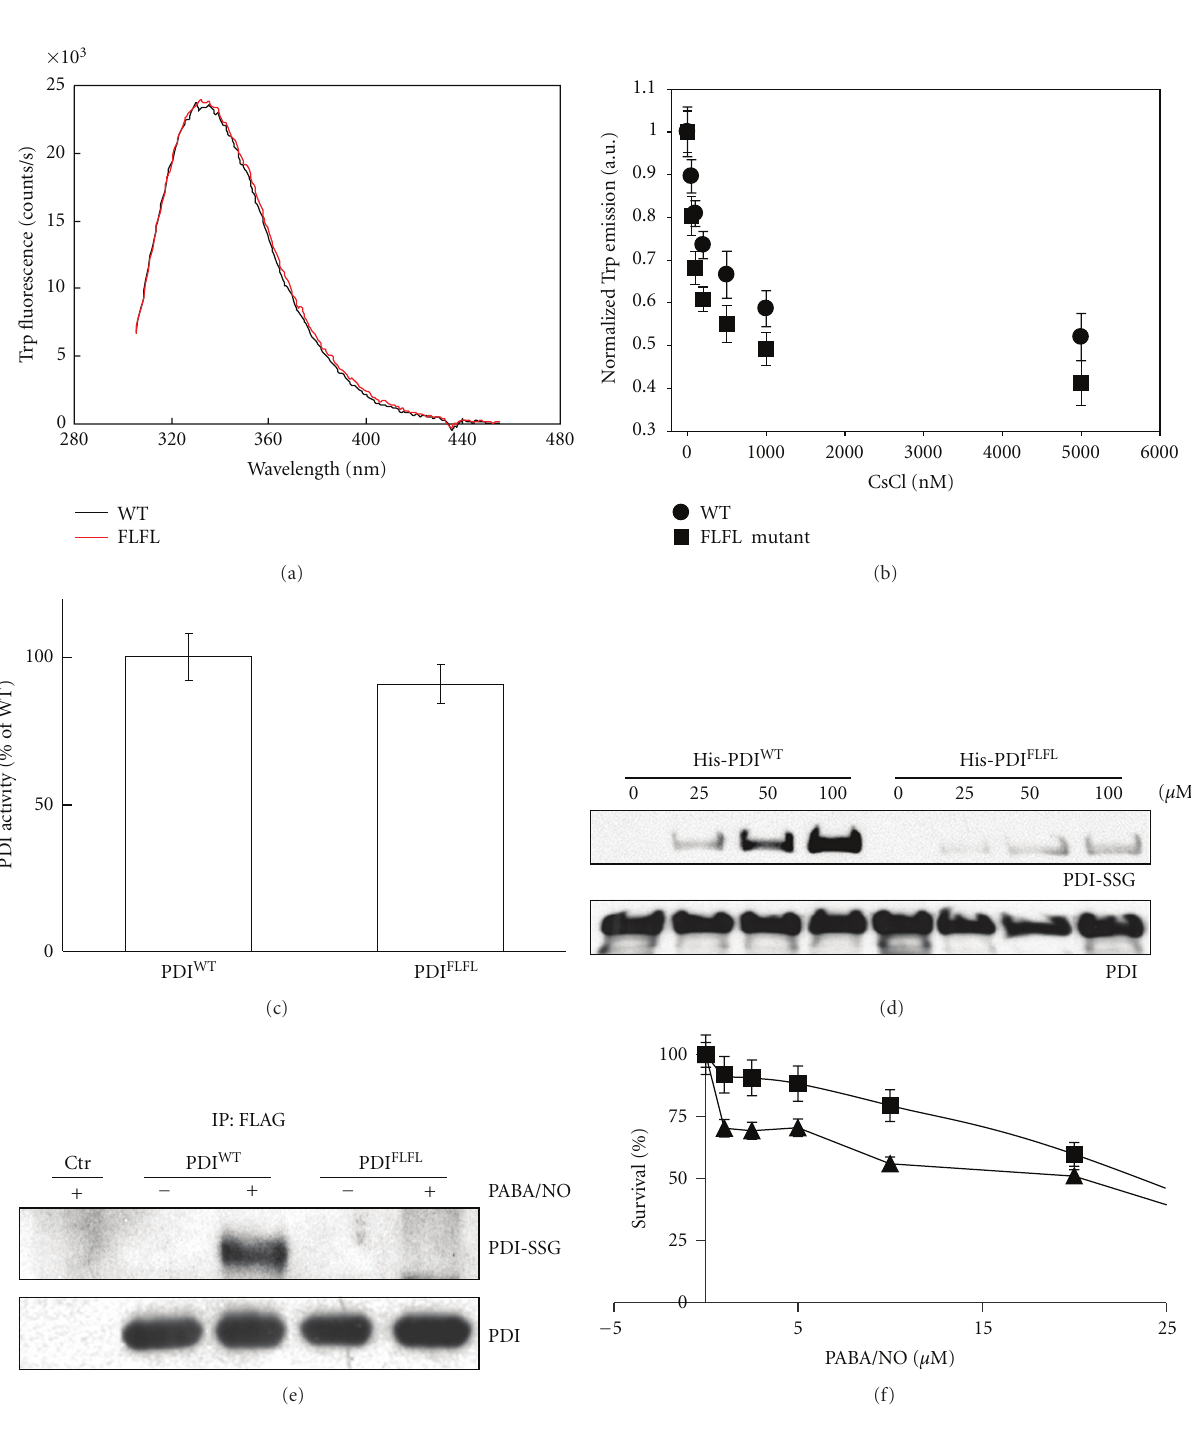
Figure 7: Mutations impair PABA/NO-induced S-glutathionylation of PDI . (a) Spectroscopic analysis of PDI-WT (black) and PDI-FLFL (red) was performed using trypophanyl fluorescence of the purified proteins. (b) Quenching experiments were performed to further assess protein folding for PDI-WT ( • ) and PDI-FLFL ( (cid:2) ). (c) The enzymatic activity of PDI-WT and PDI-FLFL was evaluated using the insulin turbidity assay. No statistical di ff erences were observed in the folding (a-b) or isomerase activity (c), P > 0 . 05. (d) S-glutathionylation of PDI-WT and PDI-FLFL was evaluated following drug treatment. (e) MCF7 cells overexpressing PDI-WT or PDI-FLFL were treated with DMSO or 20 μ M PABA/NO. Following immunoprecipitation, the samples were evaluated by Western blot with anti-S-glutathionylation and anti-PDI antibodies. (f) MCF7 cells transfected with control ( (cid:3) ) or PDI-FLFL ( (cid:2) ) were seeded in a 96-well plate and treated with 0–25 μ M PABA/NO. Cell viability was measured at 72 h with the MTT assay [14]. Data represent the mean for 3 independent experiments ±